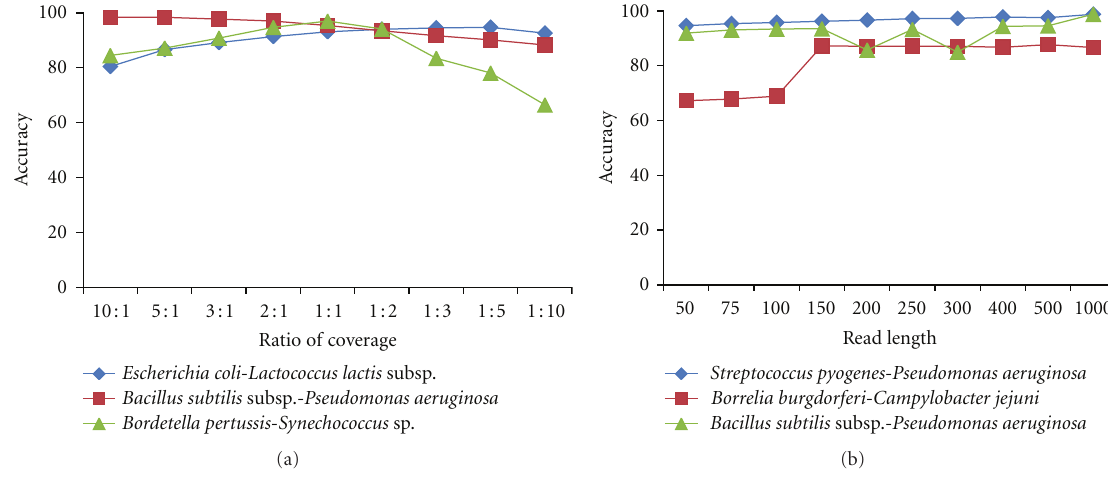
Figure 5: Performance of Poisson mixture model at (b) di ff erent reads lengths (50–1000 bp), (a) di ff erent coverage ratios in a 2-species datasets. Datasets with low δ ∗ values (100–150) were